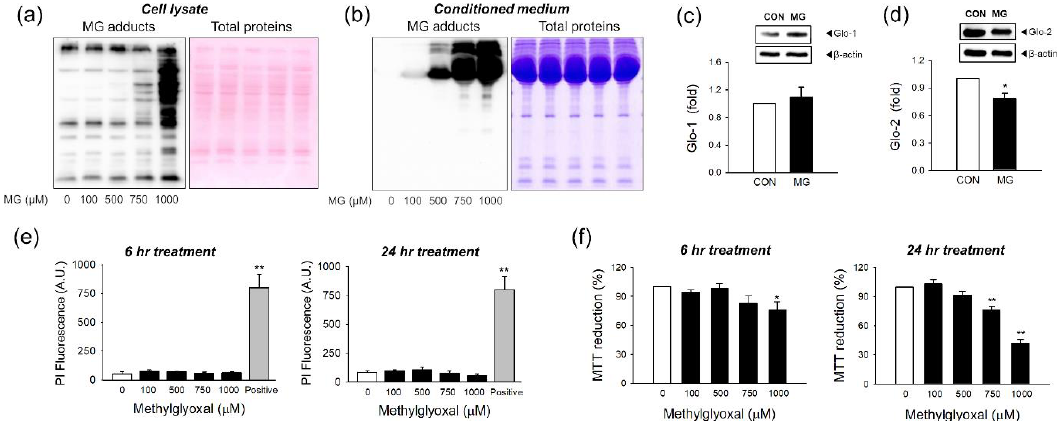
Figure 1. Formation of Methylglyoxal (MG)-adducts and alteration of cell viability in bEnd.3 cells after MG treatment. ( a – d ) bEnd.3 cells were incubated with MG at different concentrations (0 – 1000 μM) for 24 h. MG -adduct formation in ( a ) the cell lysate or ( b ) the conditioned medium was determined by western blotting and Coomassie Brilliant Blue staining. Representative images were shown. The expression levels of ( c ) glyoxalase (Glo)-1 and ( d ) Glo-2 were examined after cell treatment with 1000 μM MG for 24 h ( n = 3~4). ( e ) The changes in cell viability after MG exposure (6 h or 24 h) were determined by ( e ) PI staining or ( f ) MTT assay ( n = 3). Data are presented as the mean ± SEM. * p < 0.05, ** p < 0.01 vs. control (CON). Antioxidants 2020 , 9 , x FOR PEER REVIEW